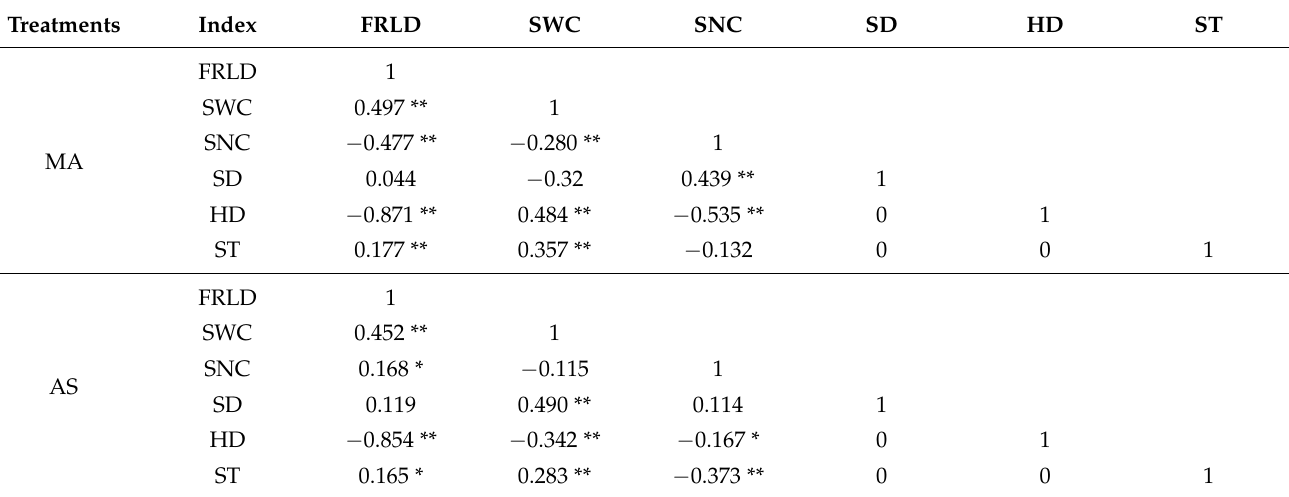
Table 1. Results of correlation analysis of fine root density and different influencing factors.